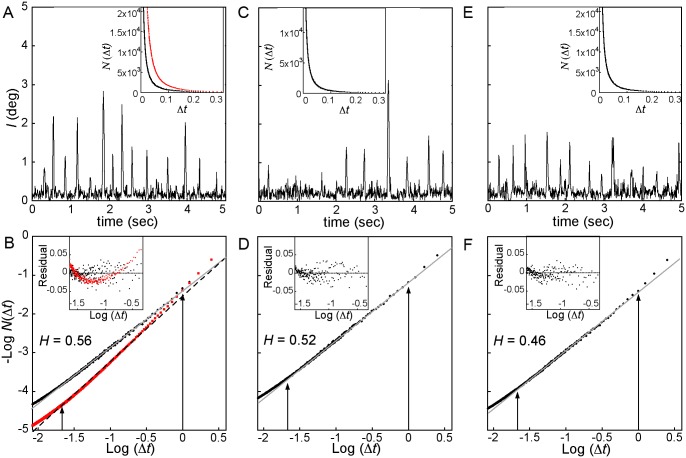
Calculated change in gaze position, l, as a function of time along with resulting variation method plot of N(Δt) in inset for (A) participant Y1, (C) FTD5 viewing the computer-generated fractal image and (E) FTD5 viewing the natural landscape.Actual data is shown as black circles and surrogate data in red squares. Note time axis in insets have been cropped in order to see details of plot. The associated plot of–log N(Δt) vs. log Δt for (B) the actual and surrogate data for participant Y1, and the data for FTD5, (D) and (F). The linear behavior observed in the actual data demonstrates the scale invariance of l (t) within the measured range. The Hurst exponent H is listed on the plots and was obtained from the slope of the linear fit (slope = 2-H). Insets shows residuals of the linear fits.